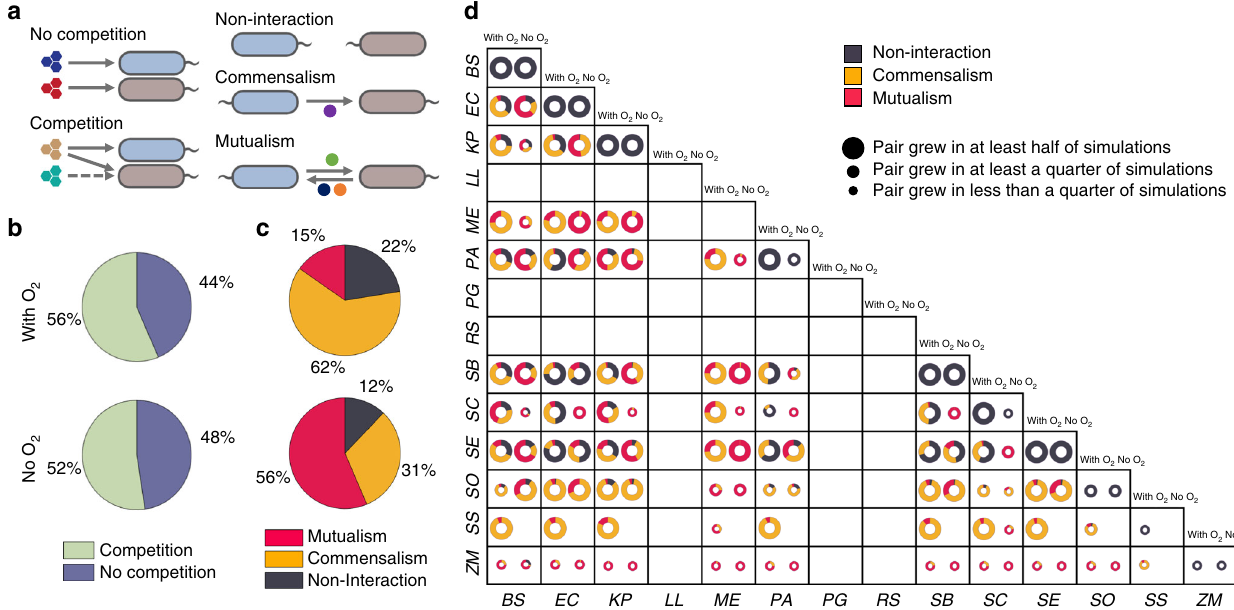
Fig. 5 Distribution of metabolic interaction types. a Schematic representation of interaction types arising from costlessly secreted metabolites. Competition is de fi ned as both organisms consuming the same carbon source. Commensalism is de fi ned as a unidirectional exchange of one or more costlessly secreted metabolites, and mutualism is de fi ned as a bidirectional exchange of one or more costlessly secreted metabolites. b Overall distributions of competitive and non-competitive interactions for oxic (out of 164,939 simulations that yielded pairwise growth) and anoxic conditions (out of 115,463 simulations that yielded pairwise growth). c Overall distributions of general interactions mediated by costless metabolites for oxic and anoxic conditions. These interactions at the level of secreted metabolites exist simultaneously with competition or no competition for a primary carbon source. d Organism-speci fi c growth outcomes and interaction type distributions. Size of circles represent the relative number of environments in which an organism was able to grow out of 5774 in silico experiments with each partner. BS : B. subtilis , EC : E. coli , KP : K. pneumoniae , LL : L. lactis , ME : M. extorquens , PA : P. aeruginosa , PG : P. gingivalis , RS : R. sphaeroides , SB : S. boydii , SC : S. cerevisiae , SE : S. enterica , SO : S. oneidensis , SS : Synechocystis , ZM : Z. (including obligate aerobes or obligate anaerobes, see Supple-